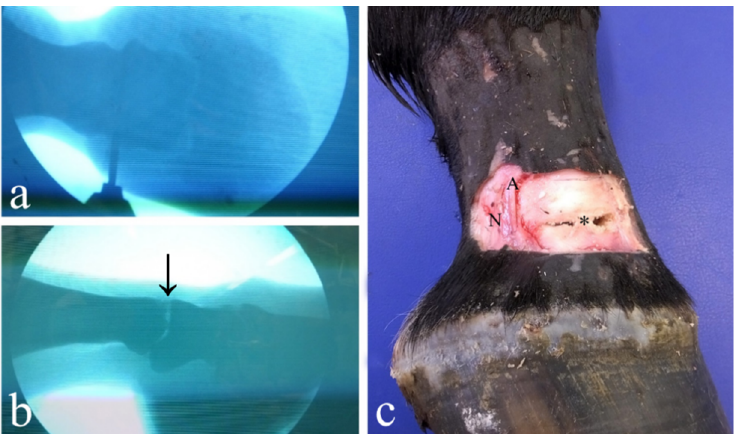
Figure 2. Lateral drilling approach under digital fluoroscopy. The correct drill bit positioning was checked several times by the use of the digital fluoroscopy (( a ) dorsal view). Note the radiolucent area (arrow) following the articular cartilage removal of the articular surface of PIPJ (( b ) lateral view) and the drill holes placed dorsally and palmar/plantar to the collateral ligament (asterisk) (( c ) lateral view). A, arteria digitalis palmaris propria lateralis; N, nervus digitalis palmaris pro- prius lateralis.